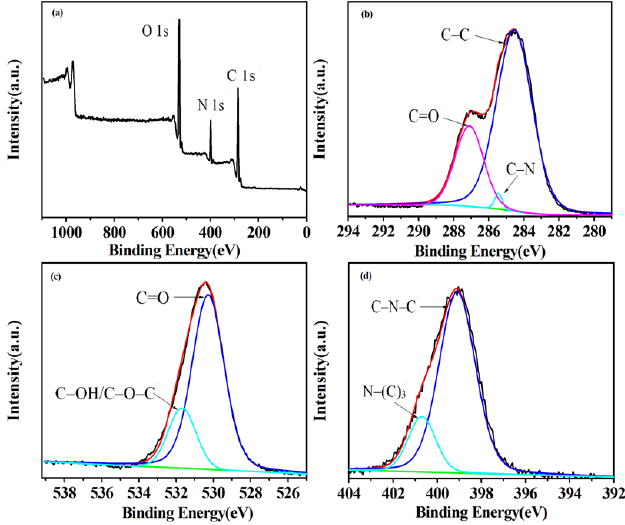
Figure 9. XPS spectra recorded from G-CDs. ( a ) Overall picture; ( b ) C 1s; ( c ) O 1s; ( d ) N 1s.